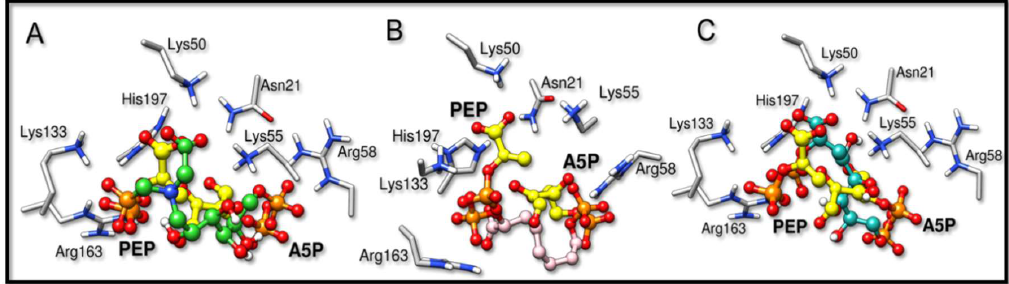
Figure 2. Overlapped structures of the bisphosphate inhibitors with PEP and A5P substrates (PDB ID: 1FXQ). The carbon atoms of the substrates are colored yellow. ( A ), ( B ), and ( C ) are the superimpositions with BPH1, BPH2, and BPH3, respectively. It is noted that the phosphate groups derived from the substrates overlap the phosphate groups of the inhibitors.